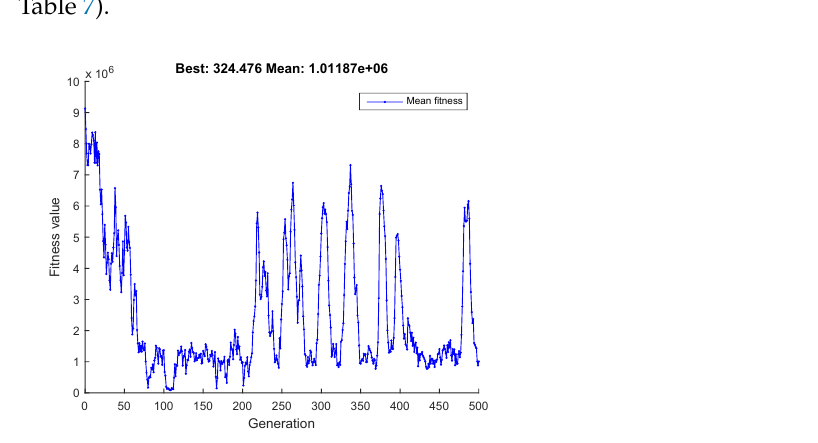
Figure 25. Suitability average in the optimization of variables pos , pot , and qtd without bars restriction.